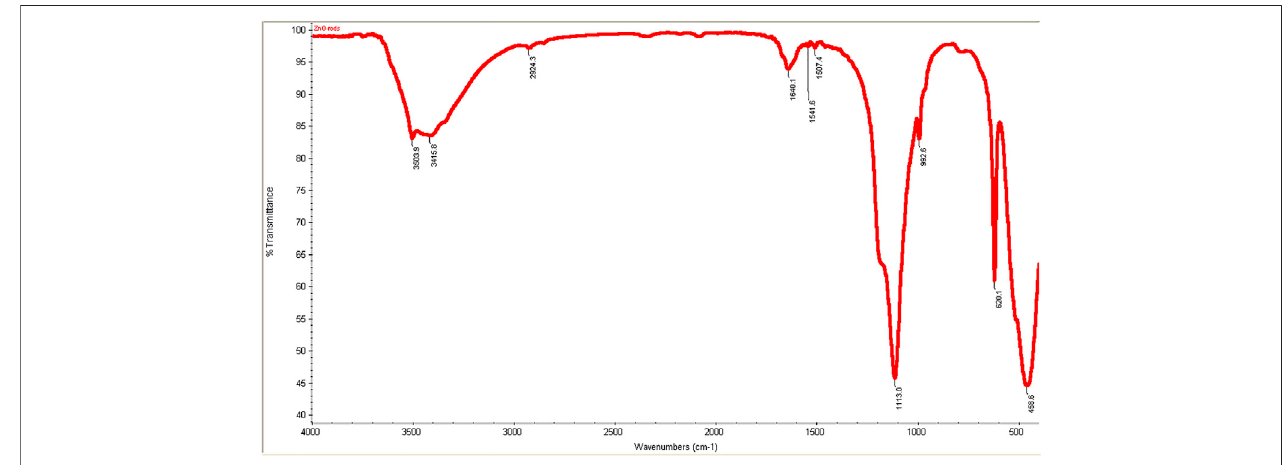
FIGURE 1 | FT-IR spectra ZnO nanorods (ZnO-NRs).